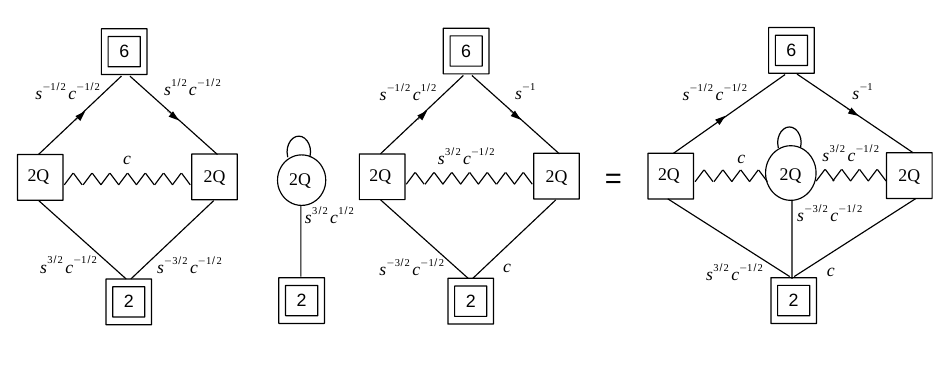
Figure 19: Gluing two basic tubes to form a tube with flux ( 1,1,0,0,0,0,0,0 ) .